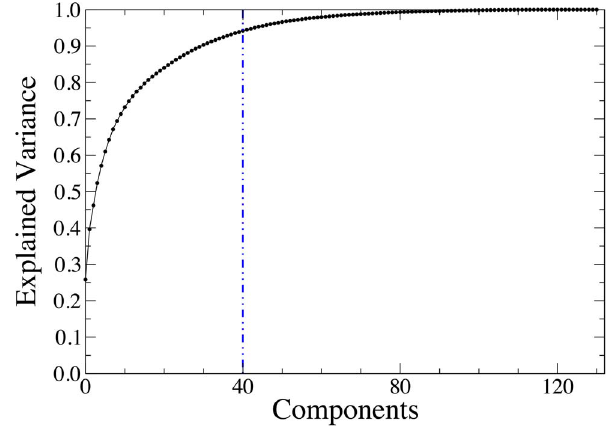
Figure 3. Cumulative variance explained as a function of the number of components. With 40 components (vertical blue line) we are able to maintain over 94% of the variance present in the data while significantly reducing the matrix size.